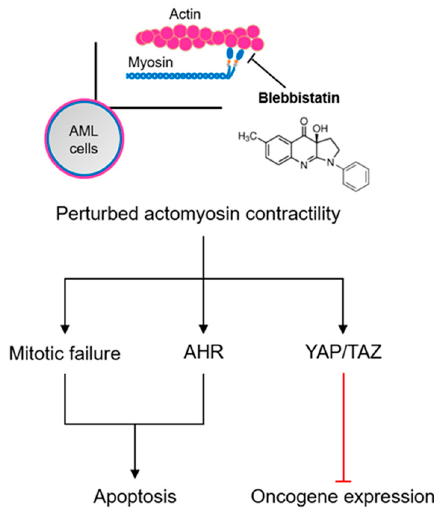
Figure 5. Schematic representation of actomyosin contractility-mediated AML progression. Perturbation of actomyosin contractility by myosin ATPase inhibition (blebbistatin) induces AML cell apoptosis and oncogene downregulation. Mitotic failure and AHR activation contribute to the apoptotic process, and YAP/TAZ transcriptional activity leads to the downregulation of leukemic oncogenes.